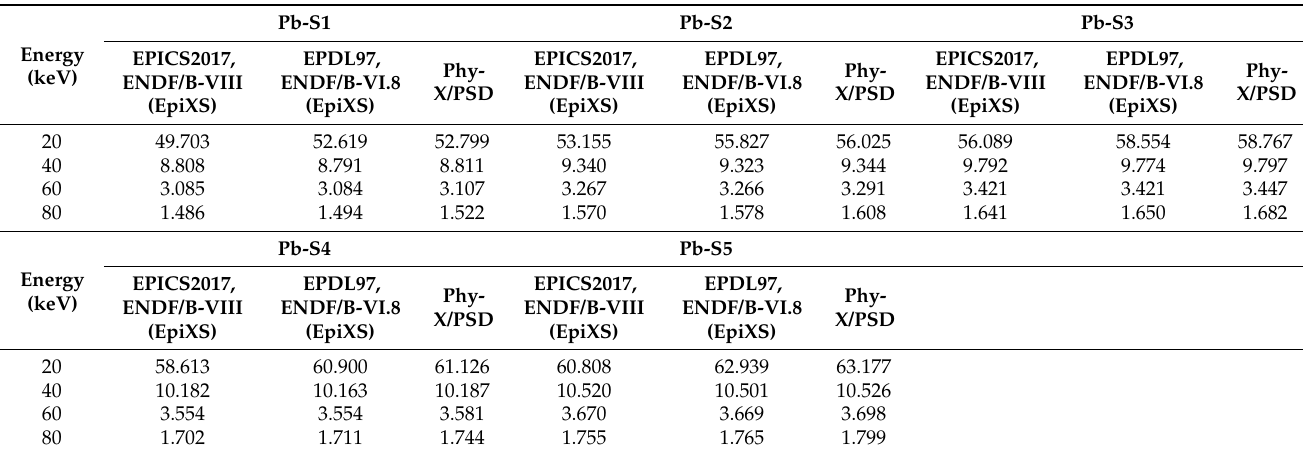
Table 3. MAC (cm 2 /g) of the